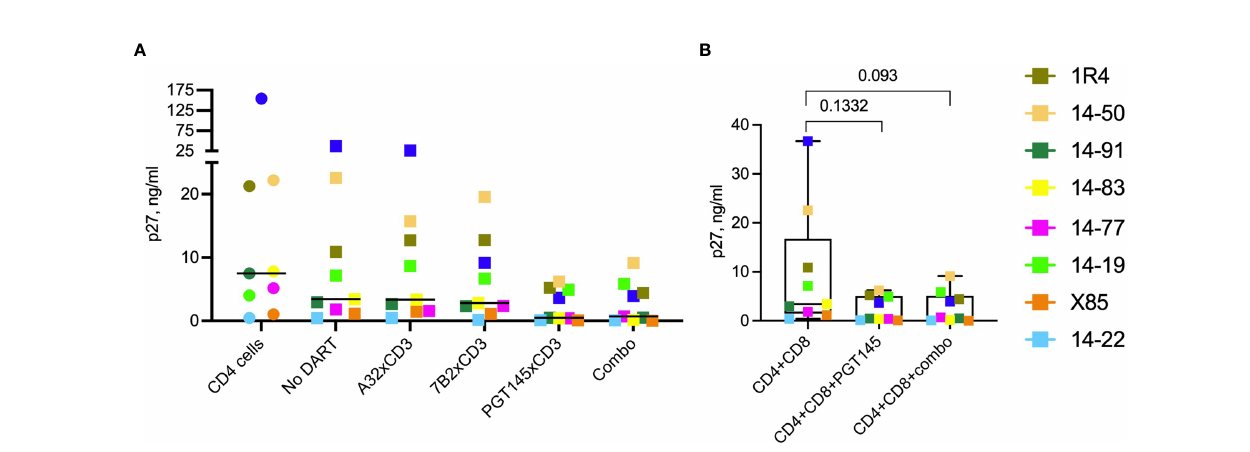
FIGURE 5 | Effect of DART molecules on virus propagation. Cultures of reactivated SHIV-infected RM CD4+ T cells alone (CD4 cells) or mixed with autologous RM CD8+ T cells and incubated in the absence (No DART) or presence of DART molecules for 48 hours. DART molecules were then washed away and the cultures were mixed with A66 feeder cells to allow virus propagation. On day 9 cultures supernatants were analyzed for SIV Gag p27 levels by ELISA (A) . The horizontal lines represent the median values. (B) Statistical comparison between the indicated groups was performed using the Wilcoxon test at a signi fi cance level of 0.05. Combo is a combination of A32, 7B2 and PGT145 DART